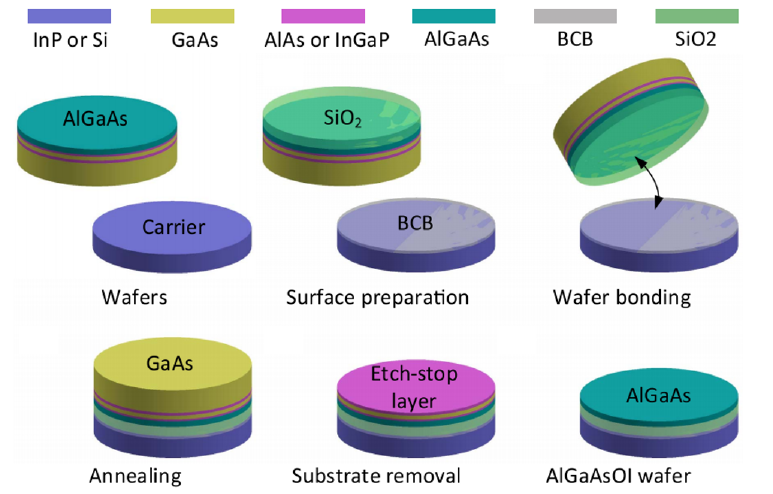
Figure 4. Fabrication process of AlGaAs-OI waveguide platform. Reprinted with permission from [177] ©The Optical